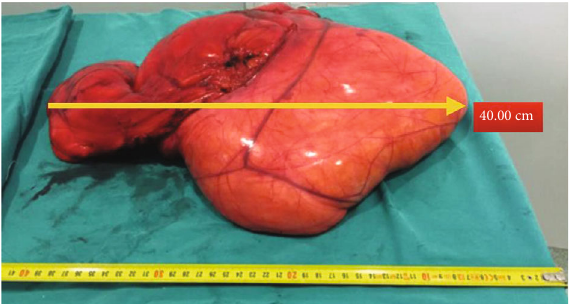
Figure 2: The lesion measured as approximately 34 cm × 26cm in size on coronal view of magnetic resonance imaging.